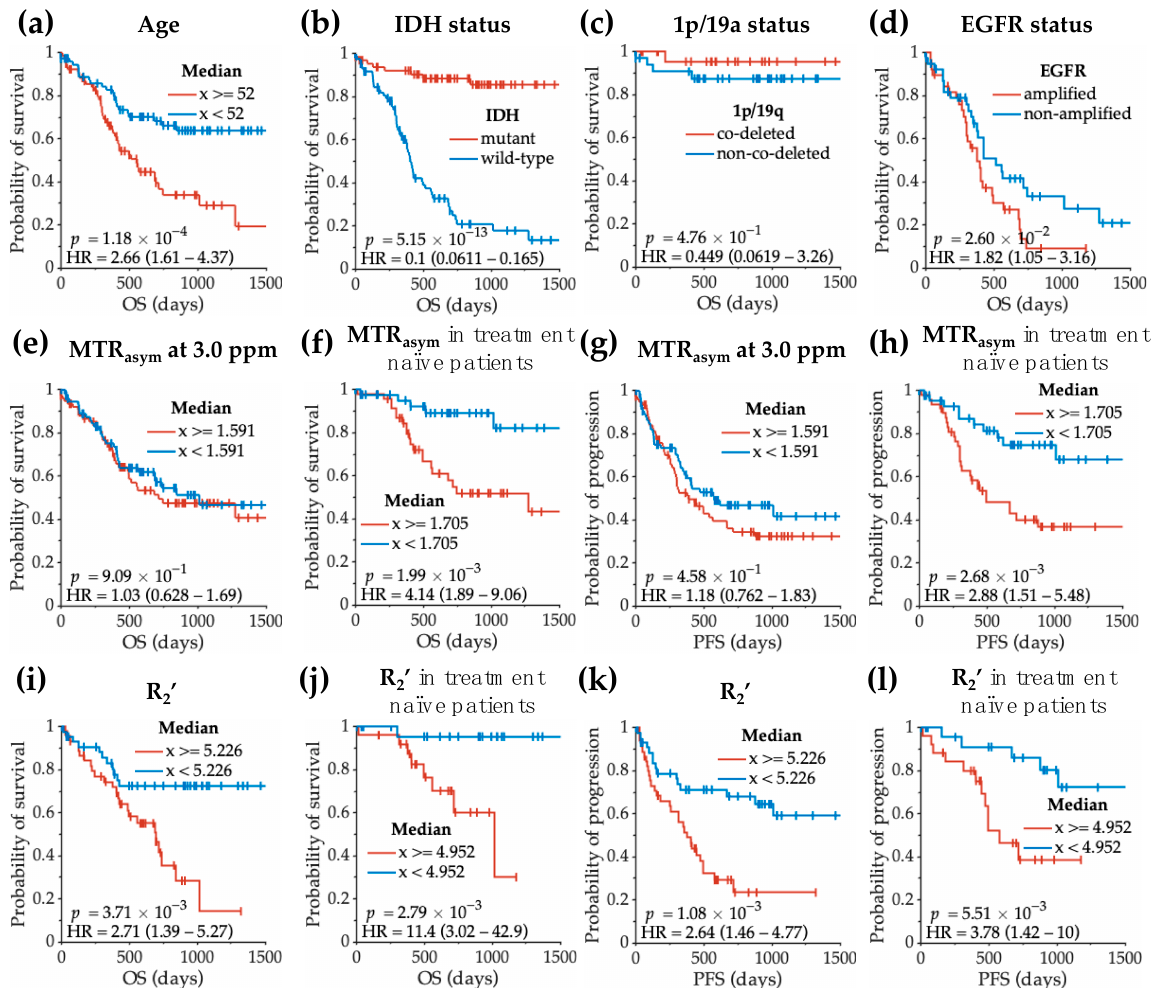
Figure 7. Log-rank analyses of residual overall survival (OS) and residual progression-free survival (PFS) with clinical variables ( a – d ) and MRI features ( e – p ). The log-rank tests were performed with the entire patient cohort if not otherwise specified. The OS refers to the residual OS from the patient scan date to the date of death. The PFS refers to the residual PFS from patient scan date to the date of disease recurrence. Tumor volume and acidic tumor volume both stratified patients into significantly different risk groups. Patients with smaller tumors had longer residual overall survival (Figure 8a,c; all patients p = 0.002; treatment-naïve patients p = 0.045). This result was also observed for patients with smaller acidic tumor volume (Figure 8b,d; all patients p = 1.28